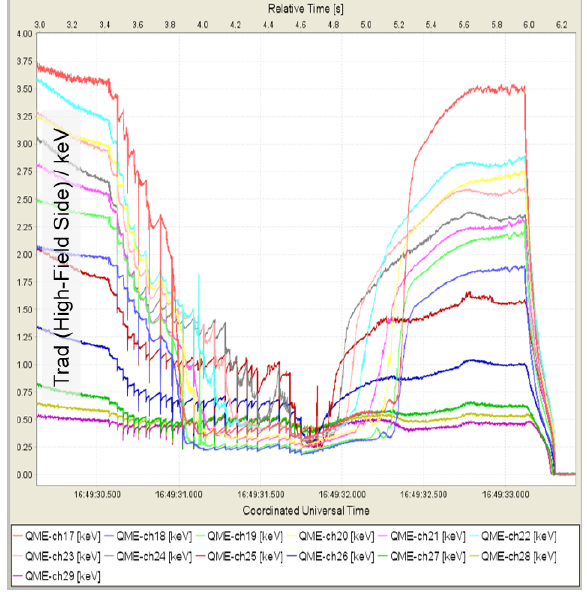
Fig. 10: Time traces of selected High-Field-Side radiometer channels during a discharge with a series of pellets driving the central ECE channels to cut-off. After the pellets the ECE signals recover channel for channel as the density is decreasing